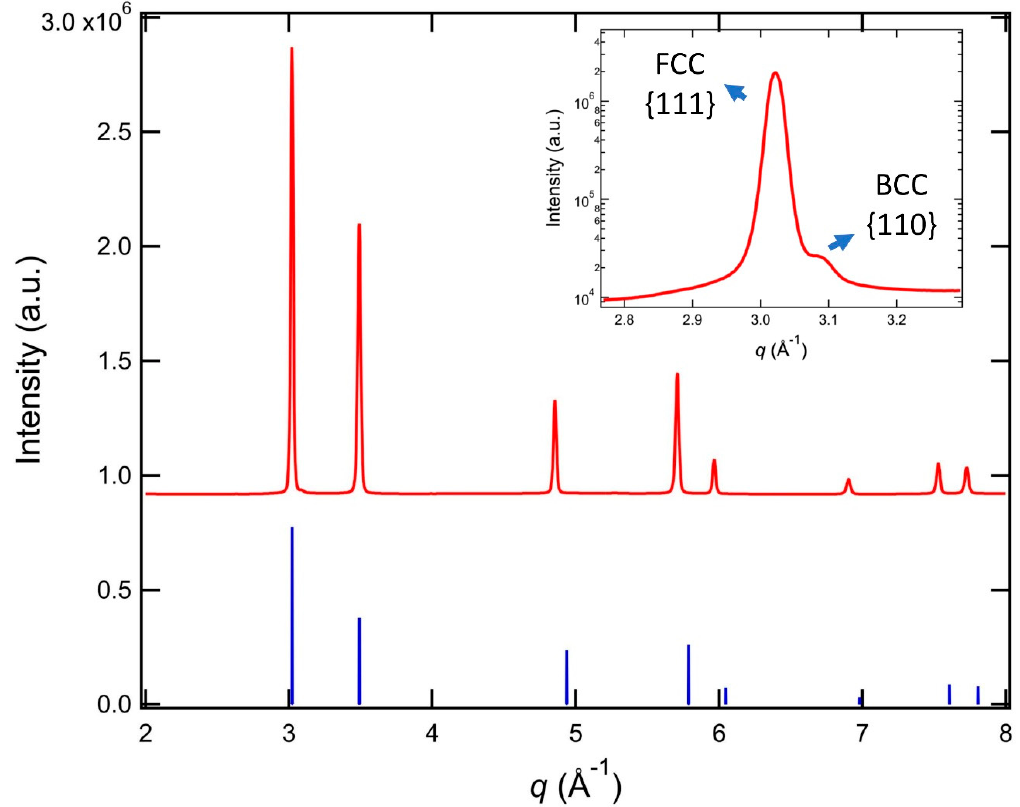
Figure 7. Synchrotron-based HEXRD of 1 mm thick as-built AM 17-4. The stick pattern was calculated with a Fm-3m symmetry and a lattice constant of 3.5997 Å. The inset shows the same XRD pattern, with the intensity on a logarithmic scale to highlight the presence of very weak BCC peaks.